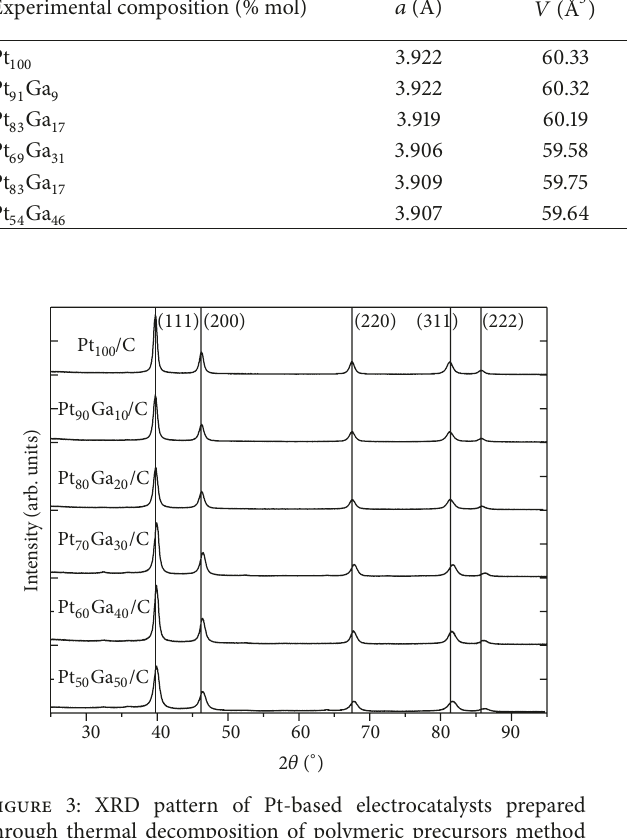
Table 2: Lattice parameter and volume and average crystallite size in the different diffraction planes of the PtGa/C electrocatalysts. Experimental composition (% mol)